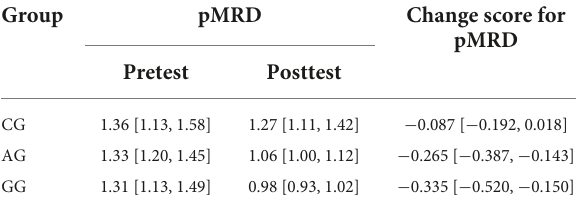
TABLE 1 Mean values and change score of pMRD with 95% confidence intervals (in square brackets) according to group and